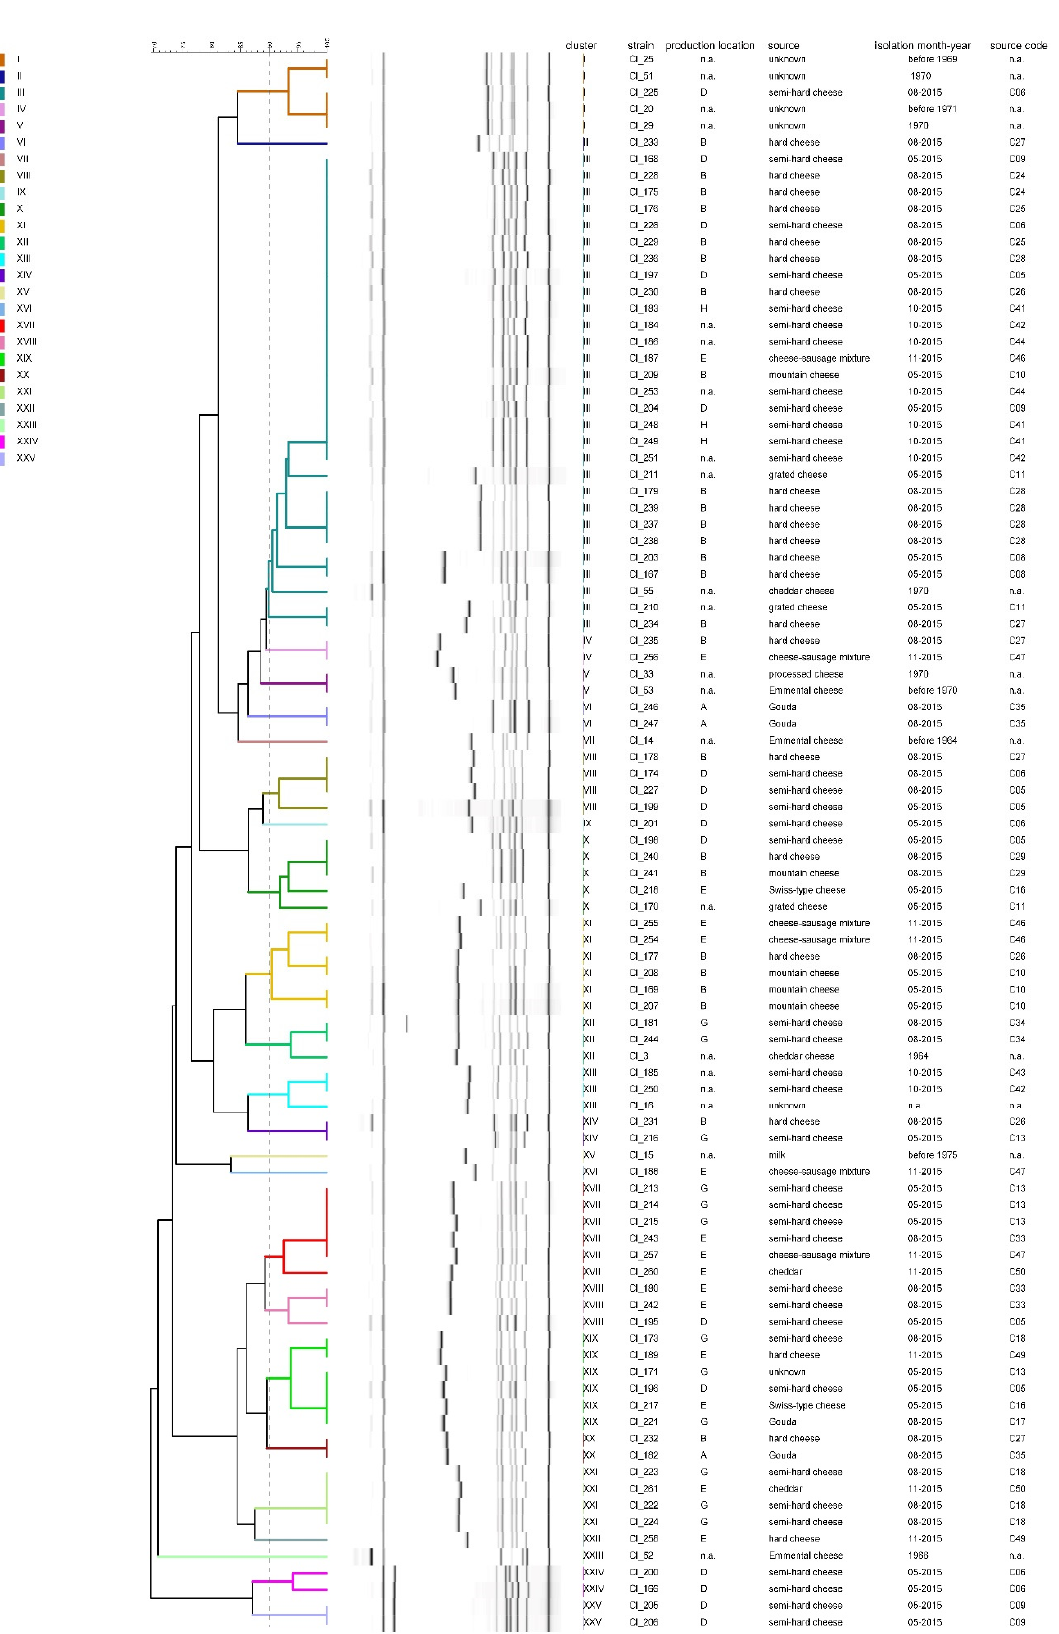
Figure 5. Dice clustering dendrogram of hexaplex-PCR analysis of 95 C. tyrobutyricum strains. The dendrogram was constructed using the unweighted pair group method with arithmetic mean (UPGMA) with similarity levels expressed as percentage values of Dice’s correlation coe ffi cient. The vertical grey dashed line indicates the threshold similarity level (90%) for cluster formation. n.a.: not